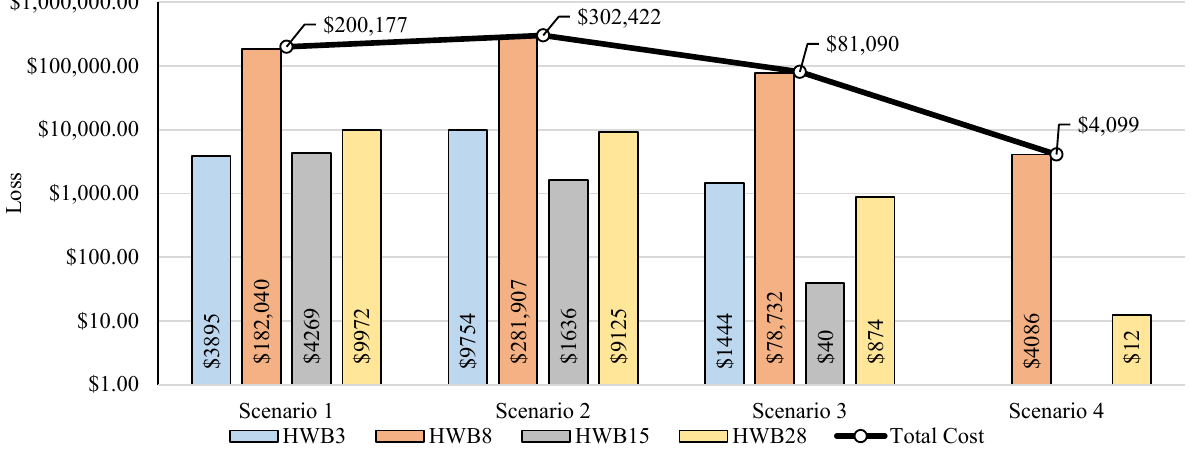
Figure 12. Total structural loss per bridge class.